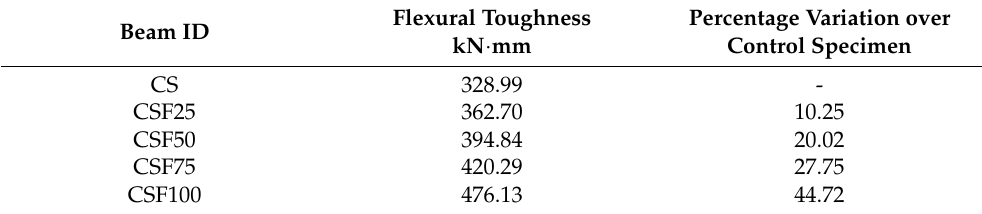
Table 6. The flexural toughness.